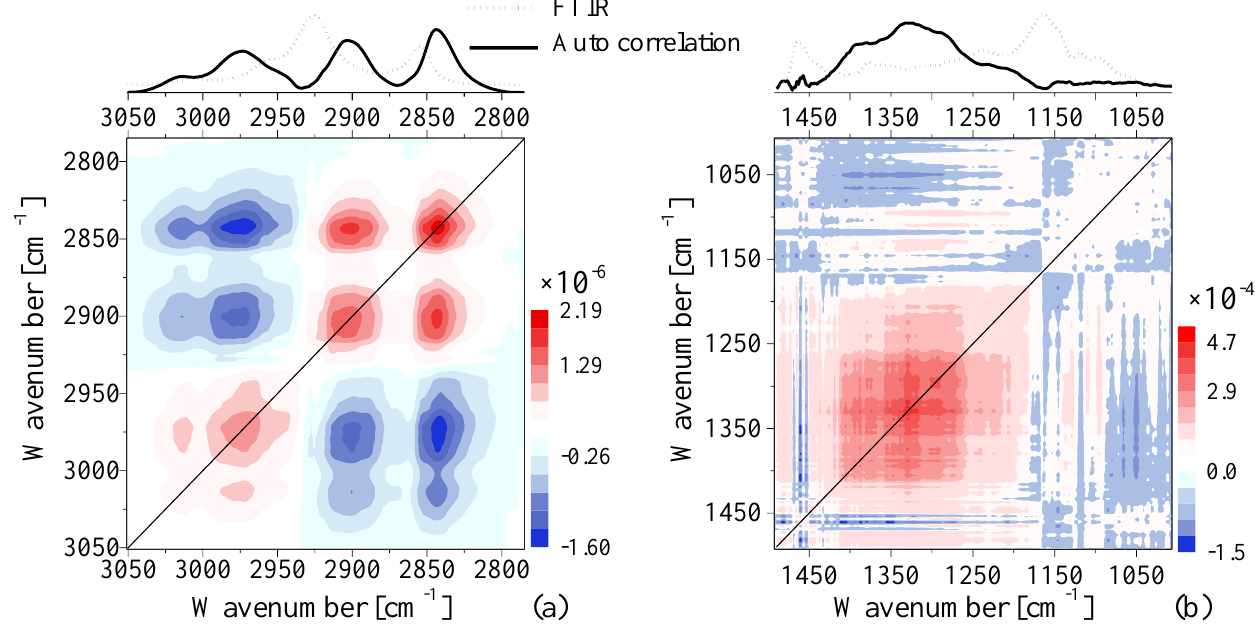
Figure 6. Contour map of the synchronous 2D FTIR correlation spectra of the EVOO–pomace mixtures at the ( a ) 3000 cm − 1 and ( b ) 1300 cm − 1 frequency windows. The spectra above the 2D plots provide the auto correlation spectrum (black solid lines) of each 2DCOS map. The average of the FTIR spectra in each window is also included for comparison (grey dashed lines).